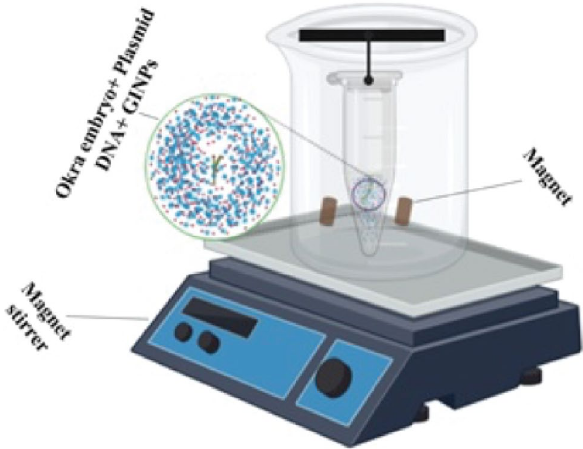
Figure 3. Magnetofection: illustration of DNA delivery using GINPs.